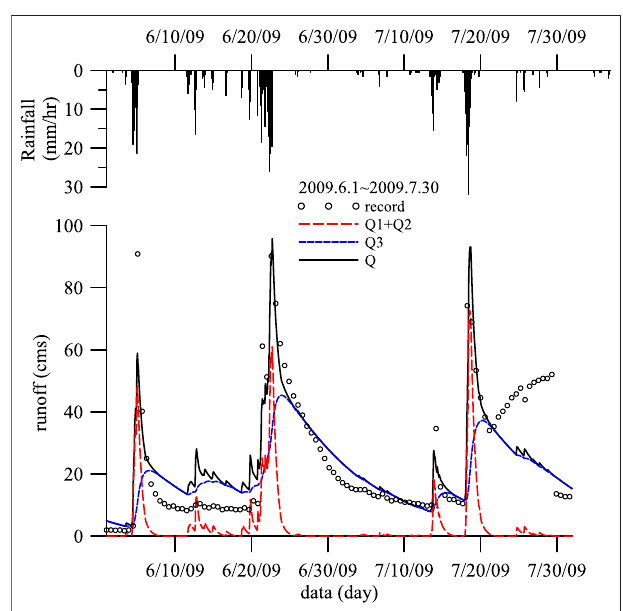
FIGURE 8 | Comparison of volume fl ow rates from each tank. The volume fl ow rate data were recorded by the A-Chyi-Ba Bridge station of the Laonung River. The measurement data between 7/22 and 7/29 may contain instrumental errors but have negligible effects on the present annual